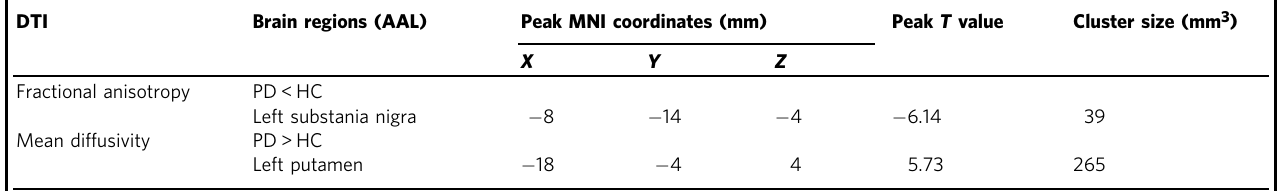
These fi ndingscorrespondtoavoxel-wiseheightthresholdof P <0.001(uncorrected)combinedwithacluster-levelextentthresholdof P <0.05(correctedformultiplecomparisonsusingtheFWErate). Abbreviations: DTI diffusion tensor imaging, AAL automated anatomical labelling, MNI Montreal Neurological Institute, HC healthy control, PD Parkinson ’ s